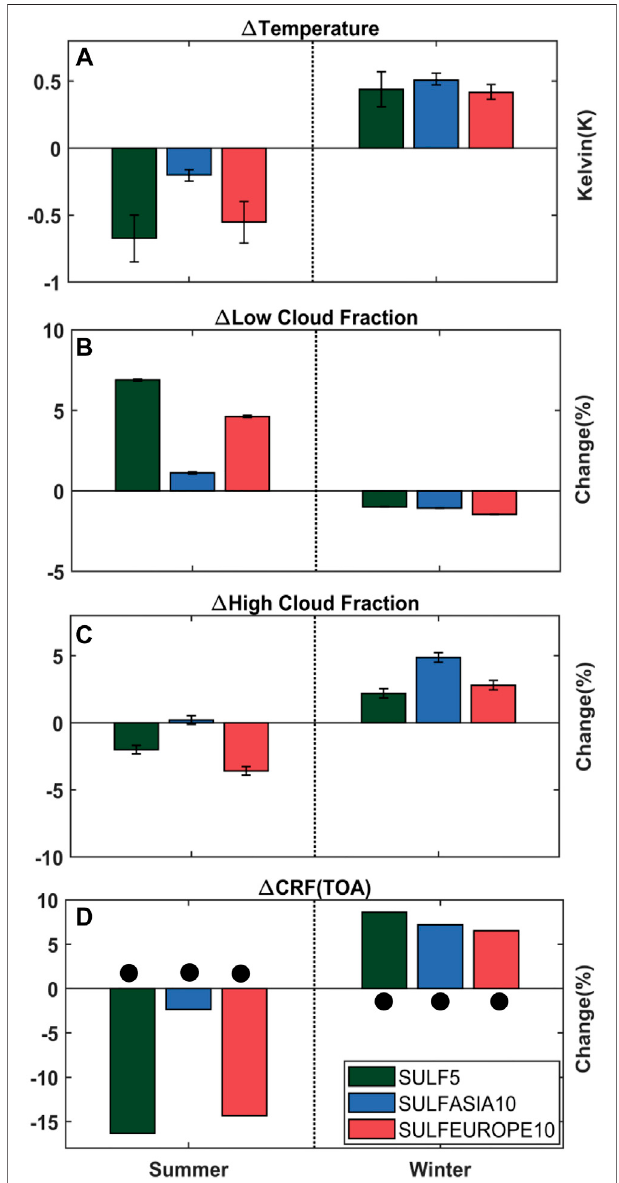
FIGURE 7 | Area averaged (60 – 80 ° N, all longitudes) for key parameters. Panel (A) showssurfacetemperatureanomaliesforsummerandwinter.Panel (B – C) shows cloud fraction changes for low and high clouds (in percentage) whereerrorbarsrepresent thestandarderrorofthepercentage change. The bottompanel (D) depictsthe cloudradiativeforcing(SW+LW)anomalies for the top of the atmosphere. The black dots are assigned where the mean differences are statistically signi fi cant ( p < 0.1) determined using the student ’ s t-test for the difference of the mean.